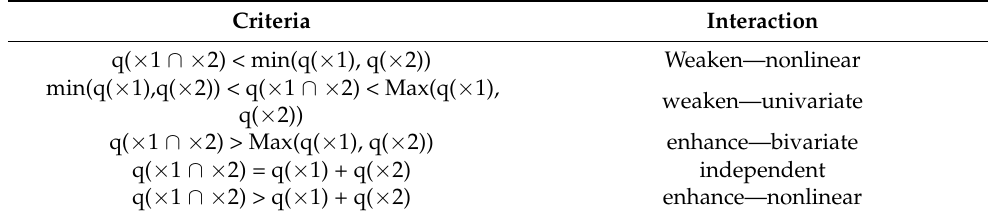
Table 2. Summary of criteria and categories associated with the interaction